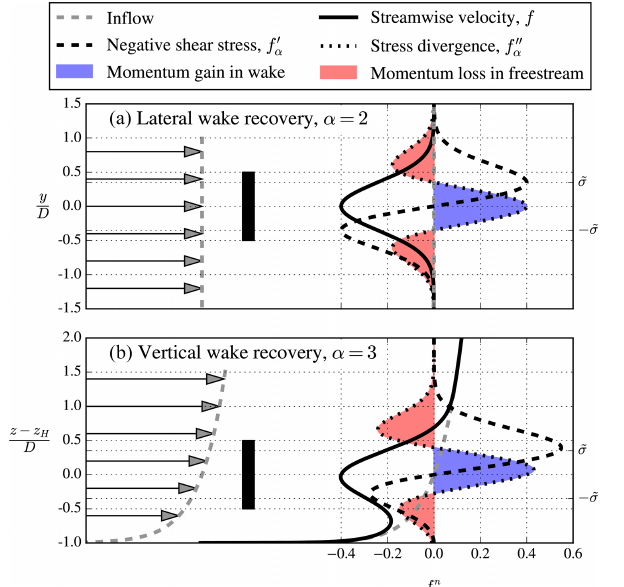
Figure 1. Gaussian velocity wake deficit, negative shear stress, and stress divergence using (cid:49) ˜ U max = 0 . 4, ˜ σ = 0 . 35, ˜ z H = 1, and ˜ z = 10 4 . (a) Lateral wake recovery at hub height. (b) Vertical wake 0 recovery at the rotor center. Black-filled rectangle indicates the rotor